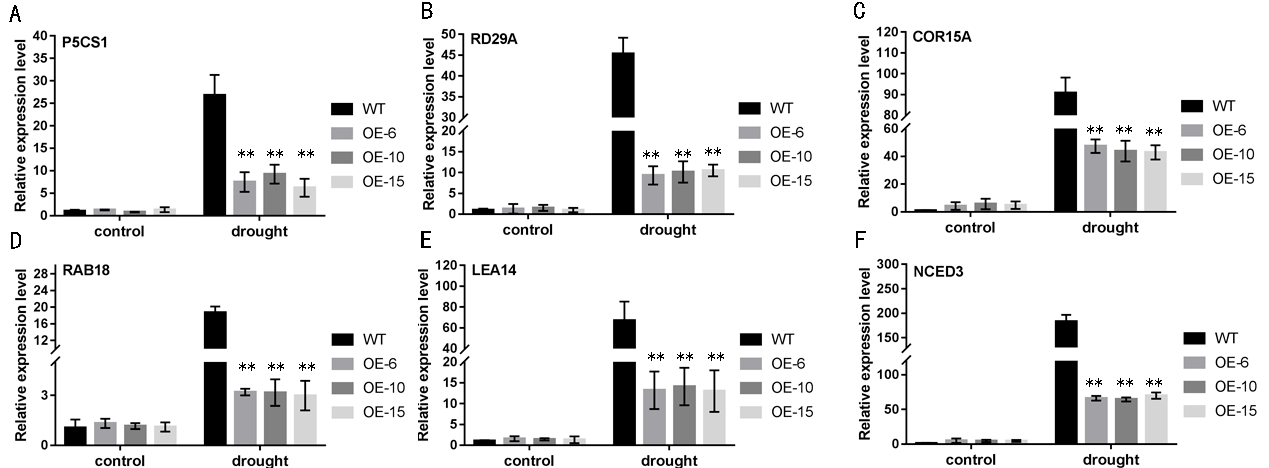
Figure 8. Expression levels of stress-related genes in wild-type and transgenic plants under drought stress conditions. The plants were grown in soil for 3 weeks and then not watered for 7 days, before determining the expression levels of P5CS1 ( A ), RD29A ( B ), COR15A ( C ), RAB18 ( D ), LEA14 ( E ), and NCED3 ( F ) by qRT-PCR. The actin gene was used as an internal reference. The asterisks over the bars indicate the significant differences between the wild-type and transgenic Arabidopsis lines. ** t -test, p < 0.01.